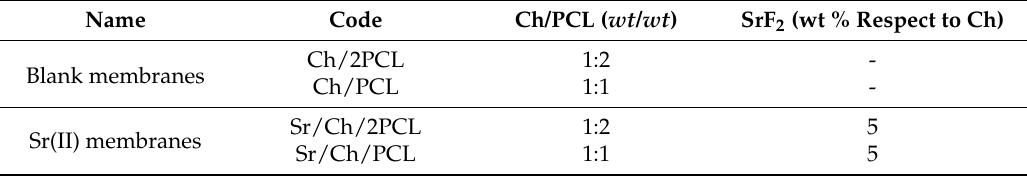
Table 1. Names and compositions of blank and Sr(II) containing membrane scaffolds. Name